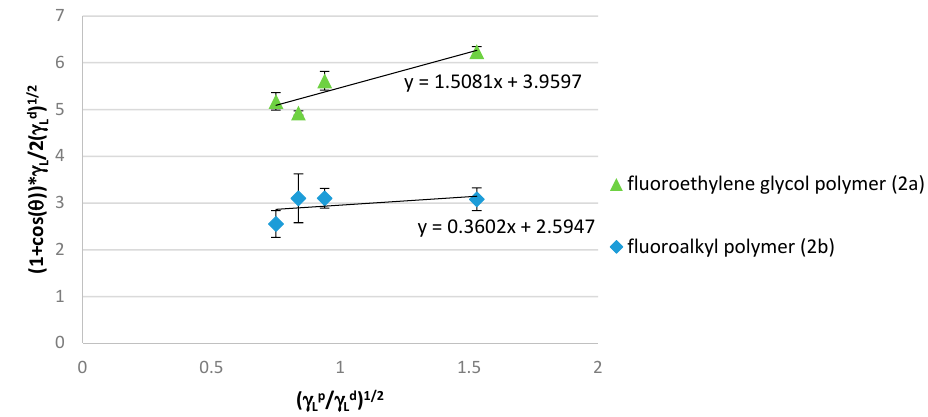
Figure 1. Zisman plots for fluoroethylene glycol polymer ( 2a ) and fluoroalkyl polymer ( 2b ).